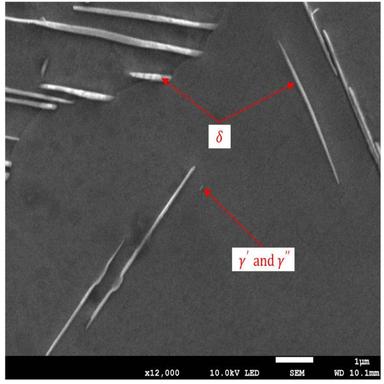
Microstructure of Inconel 718 superalloy.